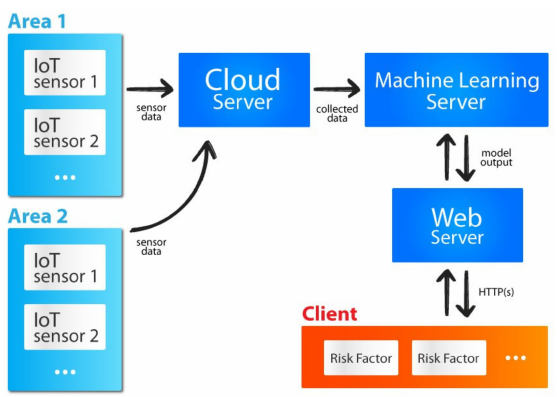
Figure 1. General structure of data analysis and risk